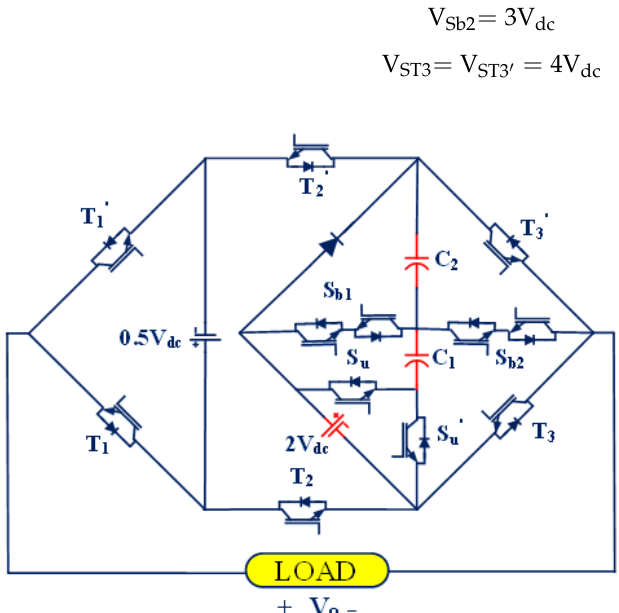
Figure 1. Structure of proposed multilevel inverter topology. Table 1. Switching